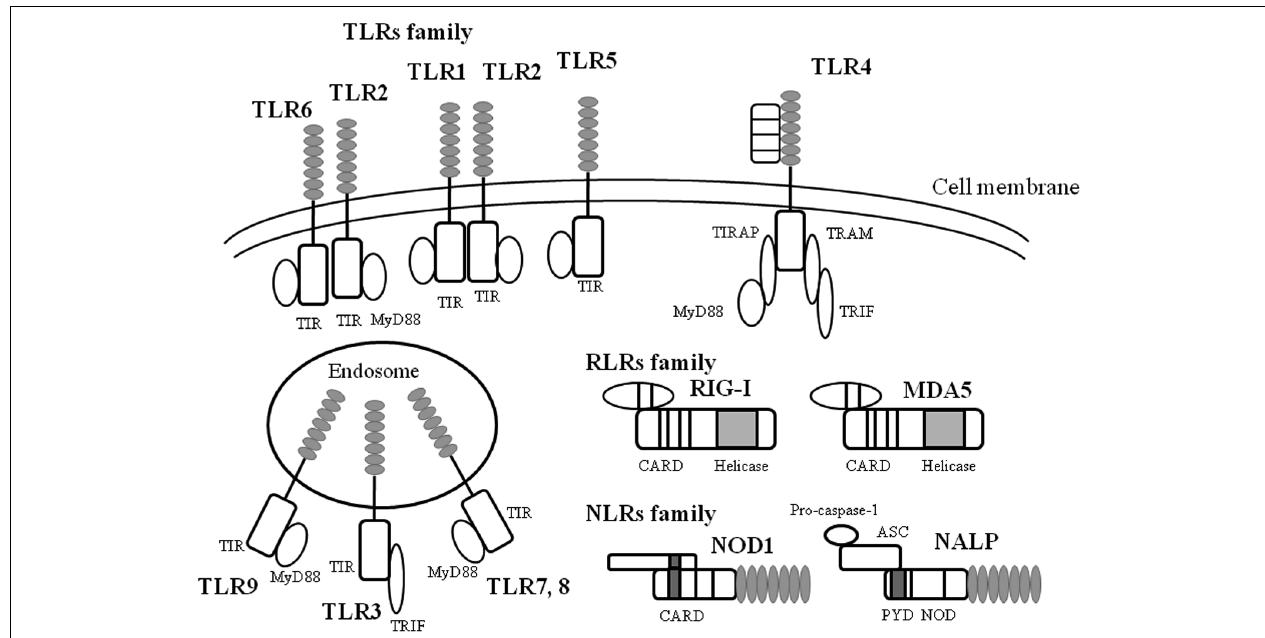
FIGURE 1 |A schematic illustration of microbial infection and innate immunity-related molecules. TLR, RLR, NLR are all expressed on and in a variety of cells in host tissues that recognize a diverse range of microbial signatures.The ectodomain of theTLR consists of leucine-rich repeats. Upon ligand stimulation, allTLRs exceptTLR3 recruit the adaptor MyD88.TLR3 is activated via the adaptor proteinTRIF (Toll/IL-1 receptor domain containing adaptor protein inducing interferon-1 β ). RLRs consist of a group of cytosolic RNA helicases. RIG-I and MDA5 are composed of two amino-terminal CARD domains and a central helicase domain. In contrast to RIG-I, MDA5 lacks the C-terminal repressor domain. NLR are composed of a central nucleotide-oligomerization domain and a C-terminal leucine-rich